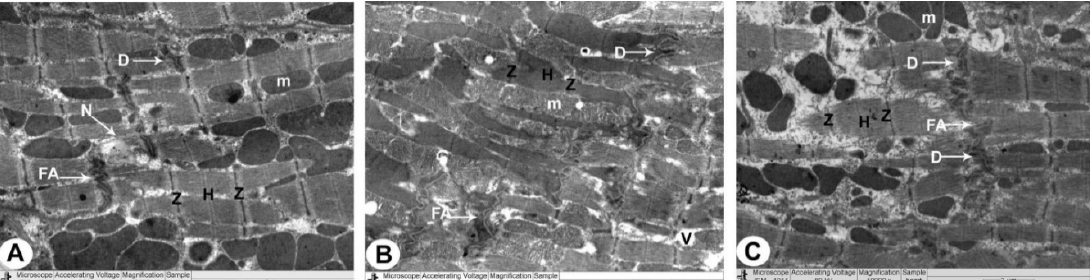
Figure 5. The right atrium is imaged using TEM in all groups of rats (intercalated disc): (×10,000). ( A ) Control rat’s group displaying a healthy intercalated disc that contains fascia adherence (FA), desmosomes (D), and gap junction (nexus) (N). Myocytes have a typical striped appearance with definite bands (Z and H) and mitochondria (m), as well as a compact cytoplasm which is filled with healthier myofibrils. ( B ) QP-treated rat’s group exhibiting intercalated discs that have been de- stroyed among disturbed myofibril, with the breakdown of muscle bands (Z and H) and pleo- morphic mitochondria (m); fascia adherence (FA) and desmosomes (D) are markedly irregular. ( C )